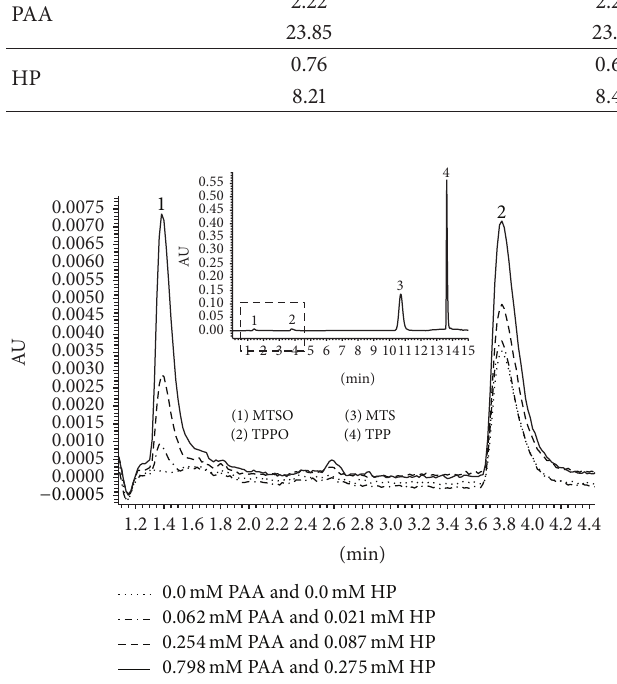
Figure 1: Derivatization reactions of PAA and HP for their determination by HPLC. Table 2: Recovery values expressed as percentage of the standards analysed with the HPLC/UV validated method. Compound